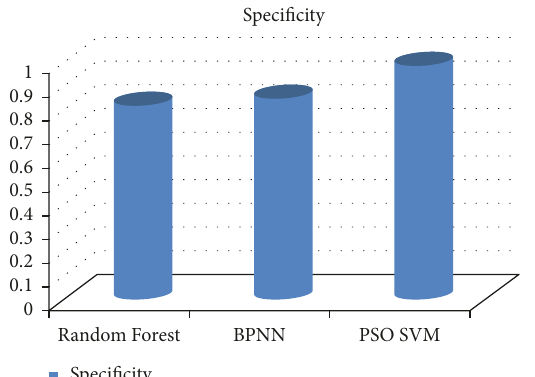
Figure 5: Specificity of classifiers for grape leaf disease classification.